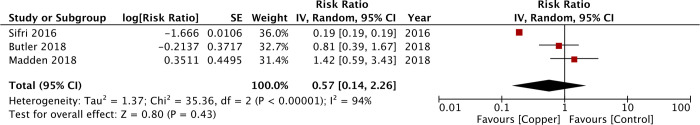
Forest plot of HAI of multi-drug resistant organism (MDRO) infection for copper-impregnated linen vs regular linen.